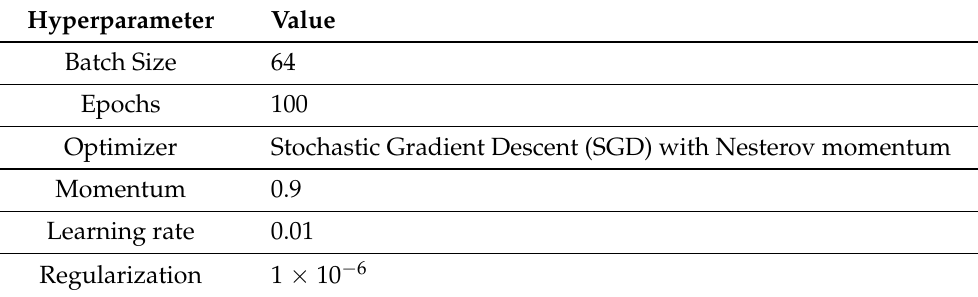
Table 4. Final values chosen for the training